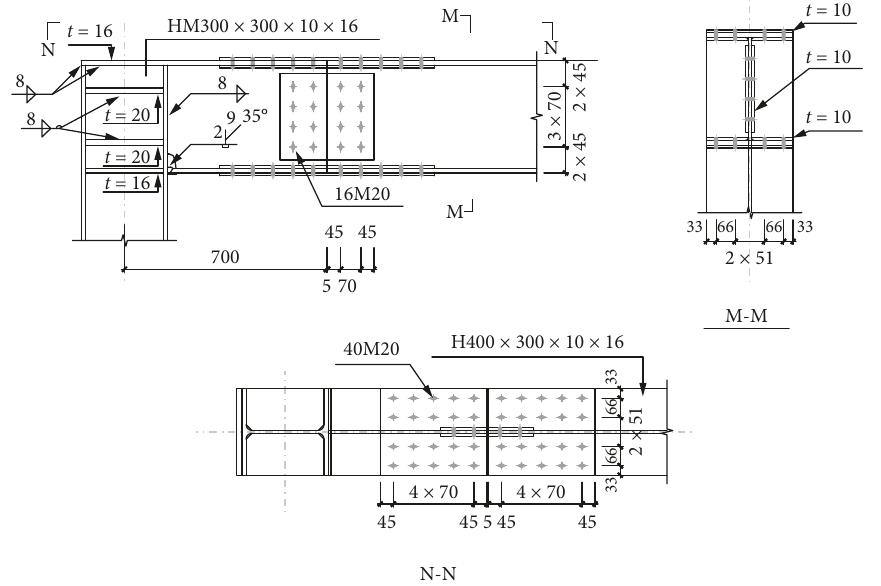
Figure 2: Details of a beam-column